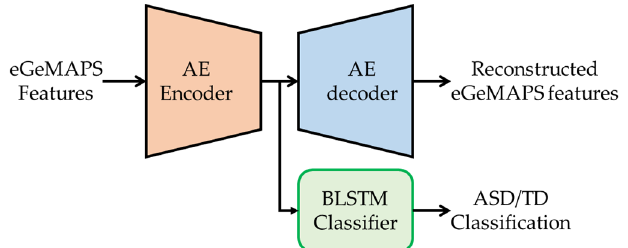
Figure 3. Network architecture for AE-BLSTM-based classifier for ASD/TD classification for joint training of AE encoder and BLSTM classifier, which we refer to as AE-BLSTM-JT.